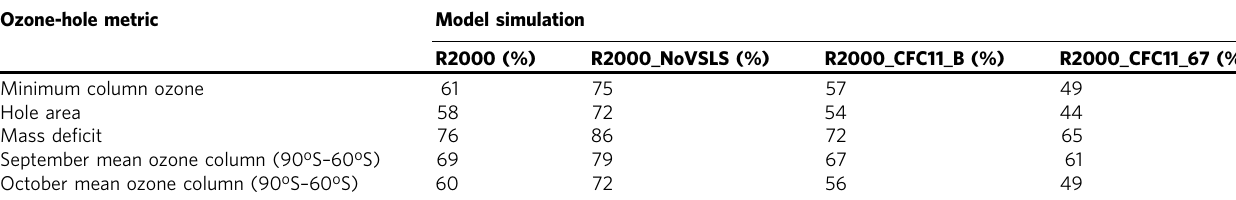
Table 3 Percentage recovery (return to 1980 values) by 2050 from four model simulations with different chlorine loading for various ozone-hole